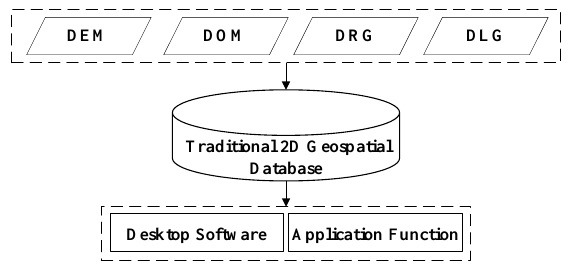
Figure 7 . Traditional 2D Geospatial Data and